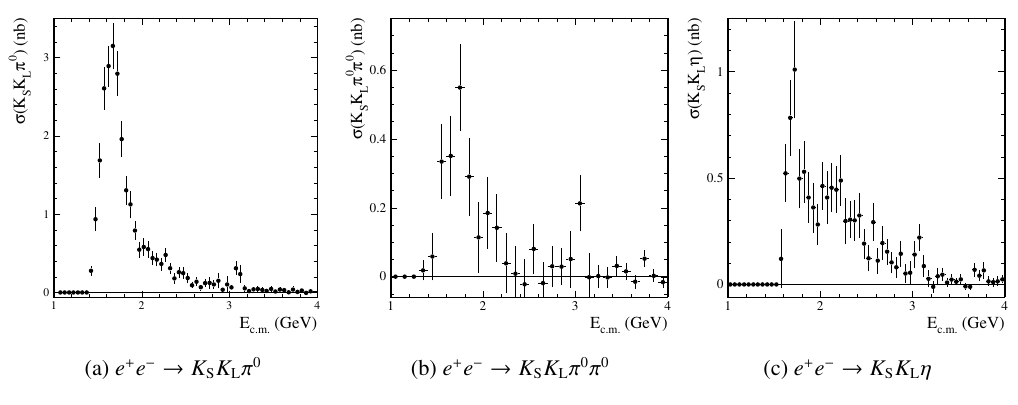
Figure 4: The cross sections containing neutral kaons [17].